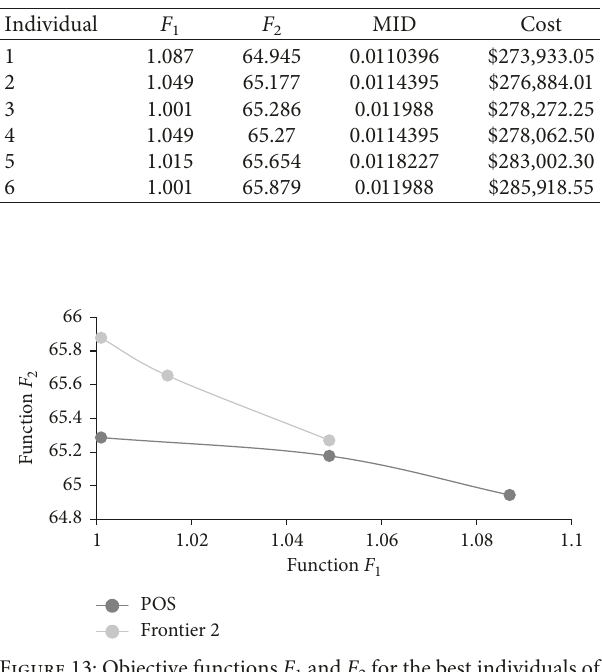
1 and F 2 for the best individuals of